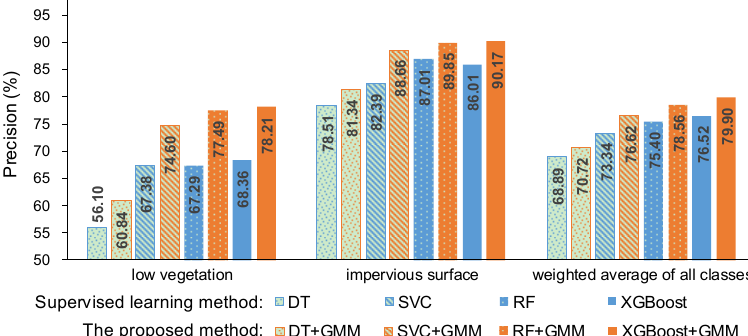
Figure 4. Precision of the supervised learning method without intensity and the proposed method.